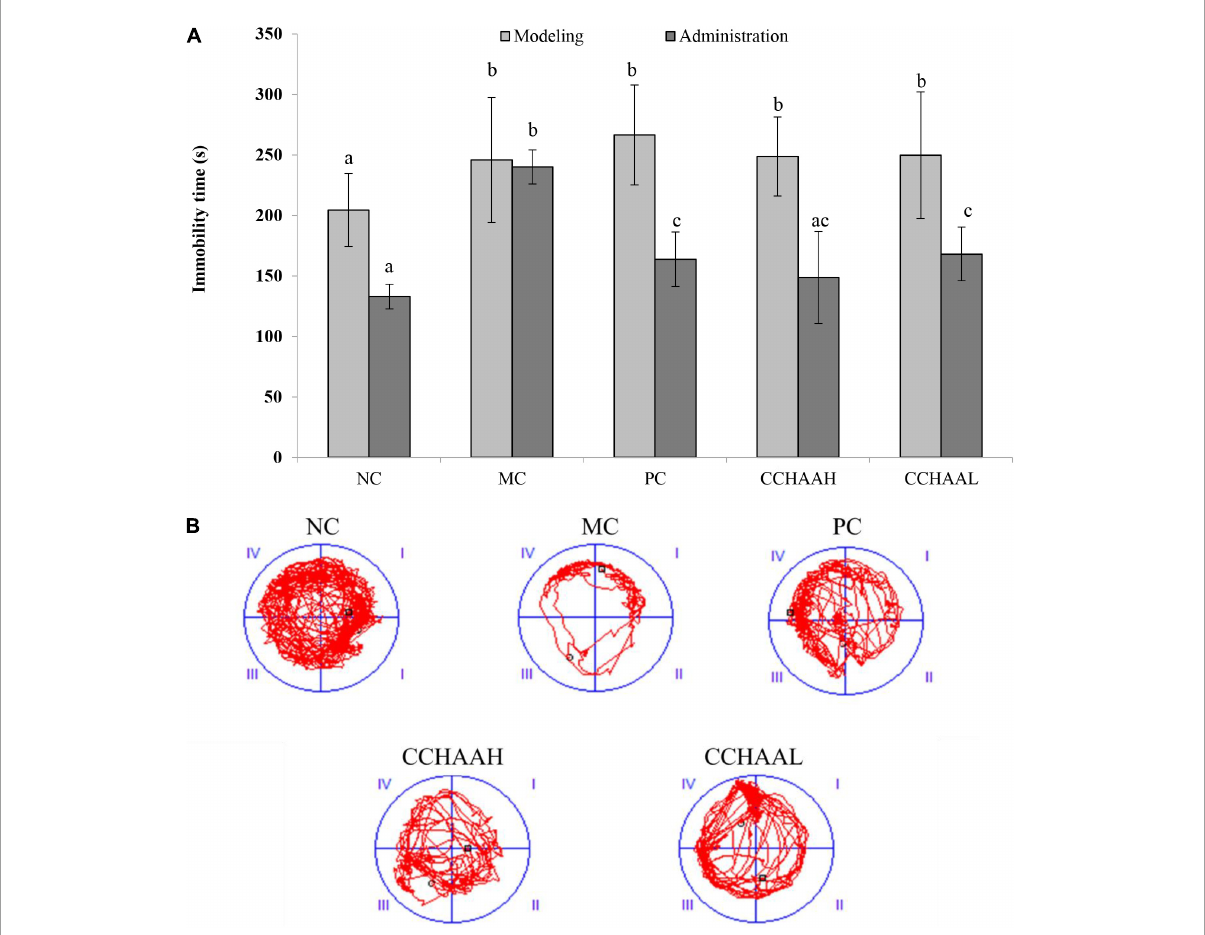
FIGURE3 (A) The effects of CCHAA formula on the behaviors of mice in the forced swimming test. Different letters indicate significant differences ( P < 0.05). (B) The total movement tracked in FST: The black dots indicate where the mice started the test, with the black boxes showing where the mice stopped after the 10-min test, and the red lines were the recorded motion track/routes of